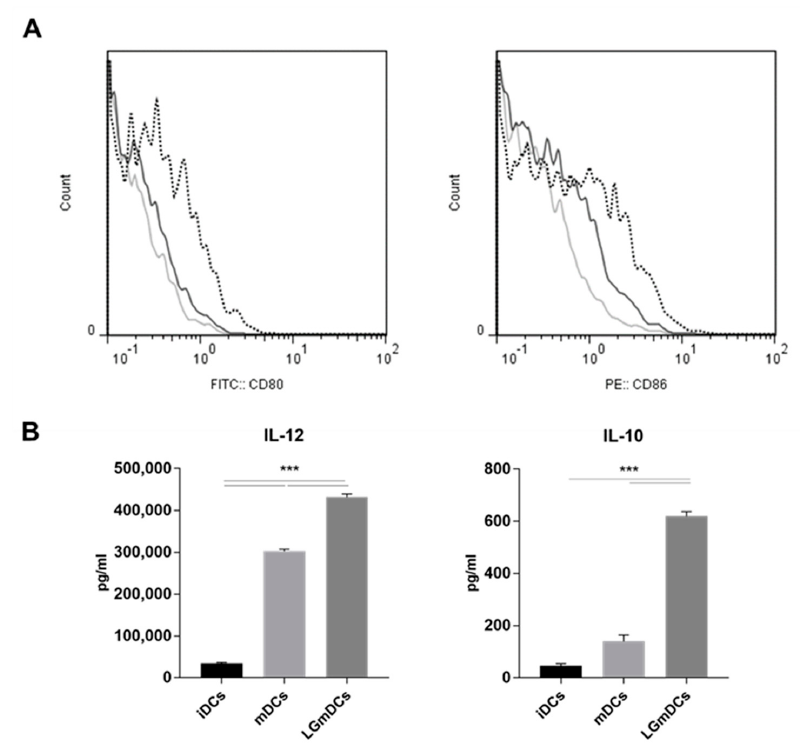
Figure 1. Phenotype of dendritic cells (DCs) cultured in X-Vivo 15 medium and challenged with L. gasseri . Immature dendritic cells (iDCs) were challenged or not with irradiated L. gasseri and then subjected to a 6-h lipopolysaccharide (LPS) pulse to induce DC maturation. ( A ) Fluorescence-activated cell sorting (FACS) analysis of DCs double-stained for CD80 and CD86; light grey line, iDCs; dark grey line, mDCs; dotted line, L. gasseri OLL2809 challenged iDCs (LGmDCs). ( B ) Cytokine analysis (Interleukin-10 (IL-10) and Interleukin-12 (IL-12))of iDCs, mature dendritic cells (mDCs), and LGmDCs. Data were collected from ungated cells and are representative of three independent experiments. *** p < 0.01 (ANOVA test).